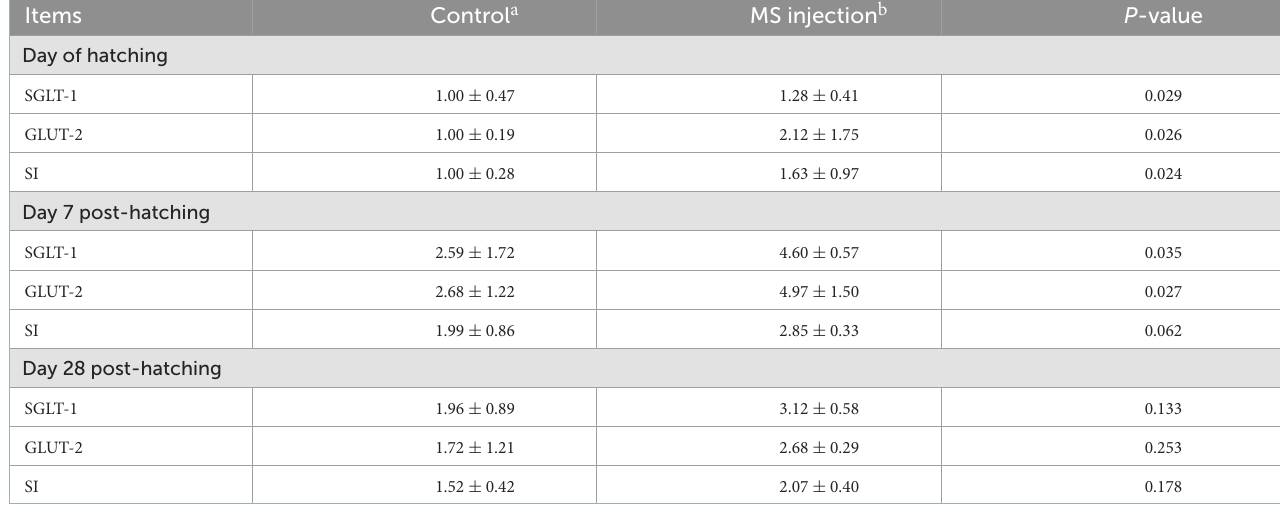
TABLE 6 Post-hatching jejunal sugar transporter gene expression of goslings as affected by the in ovo injection of maltase and sucrose.